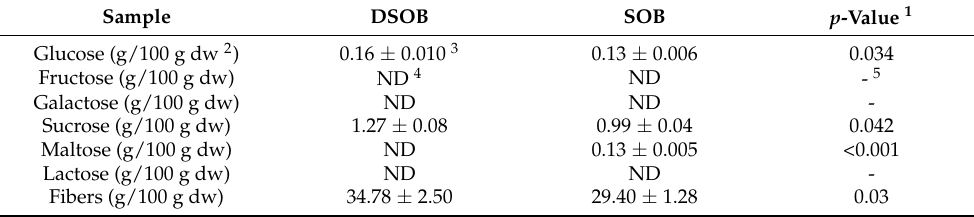
Table 6. The contents of fibers and sugars in defatted seeds of Oenothera biennis (DSOB) and seeds of Oenothera biennis